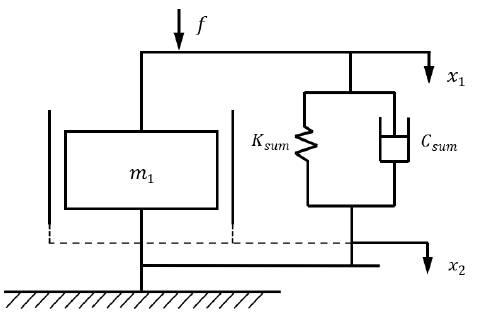
Figure 10. Tangential mechanical model of the solid–liquid interface.